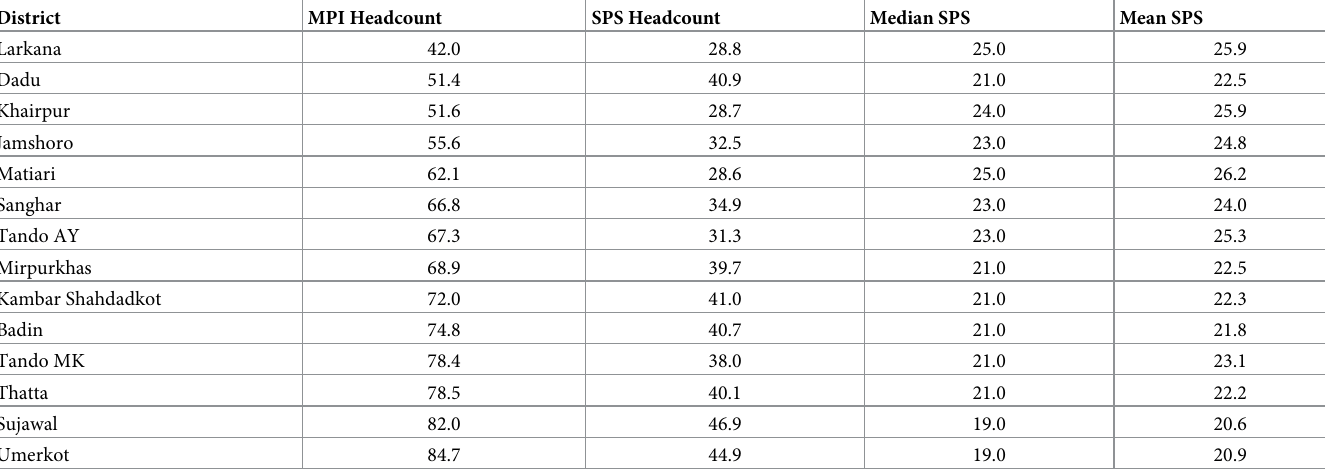
Table 2. District level poverty headcounts based on MPI (2014–15) and Simple Poverty Score (2015/16/17).